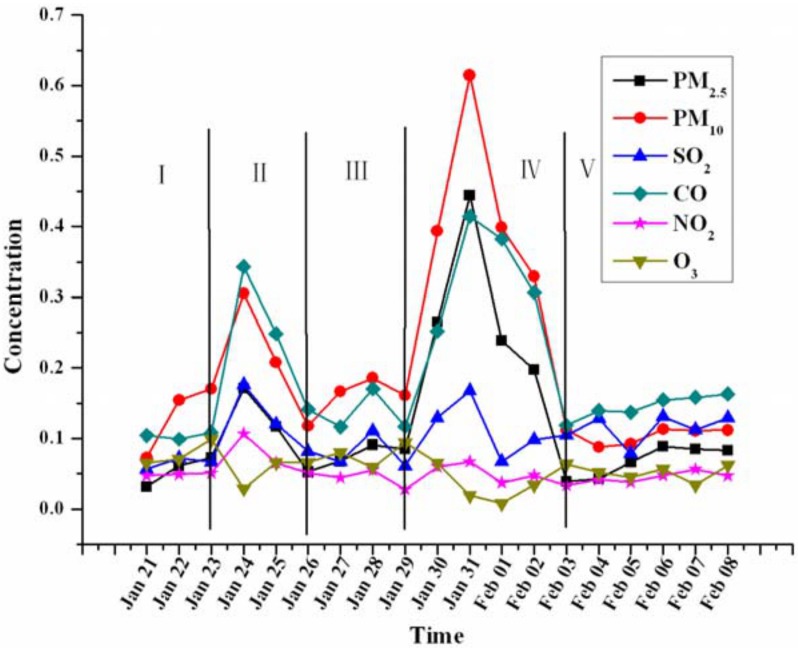
Inter-day changes of the pollutant concentrations during the two episodes for the Chinese New Year.The unit of CO is 10−1 mg m-3 and others are mg m-3.